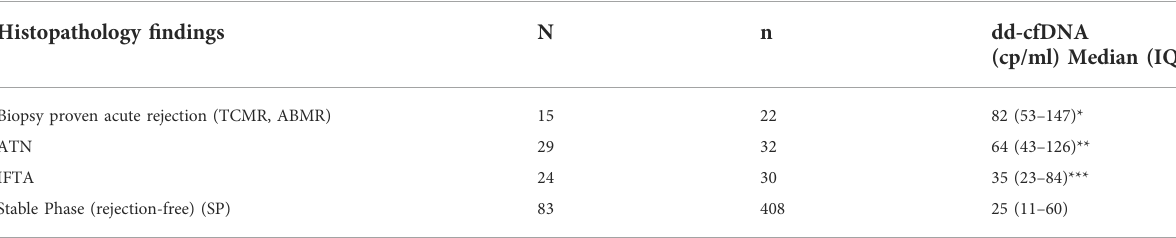
TABLE 1 Detection of rejection by absolute dd-cfDNA quanti fi cation in the fi rst year post-KTx. Prospective single center trial using ddPCR Histopathology fi ndings